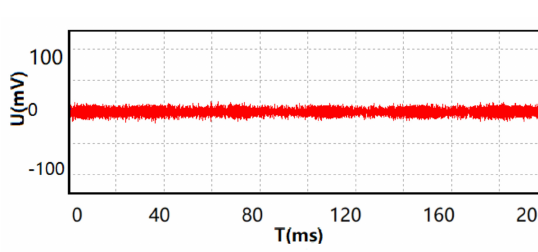
Figure 4. Original Signal.